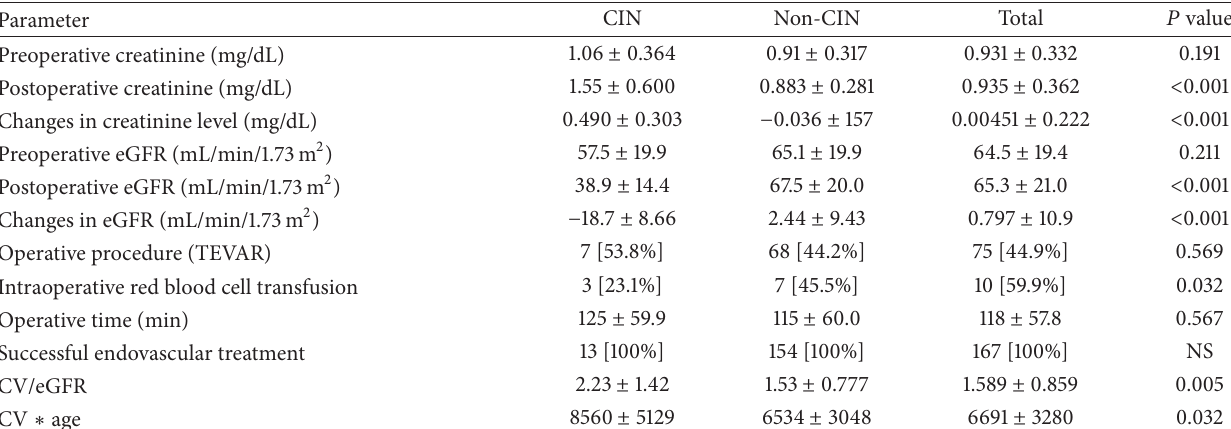
Table 2: Clinical parameters and outcomes.